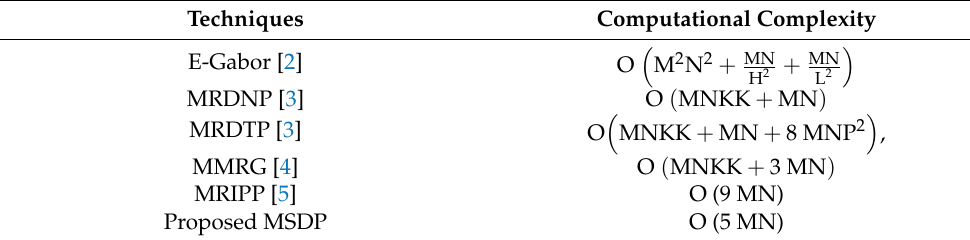
Table 13. Computational complexity of different